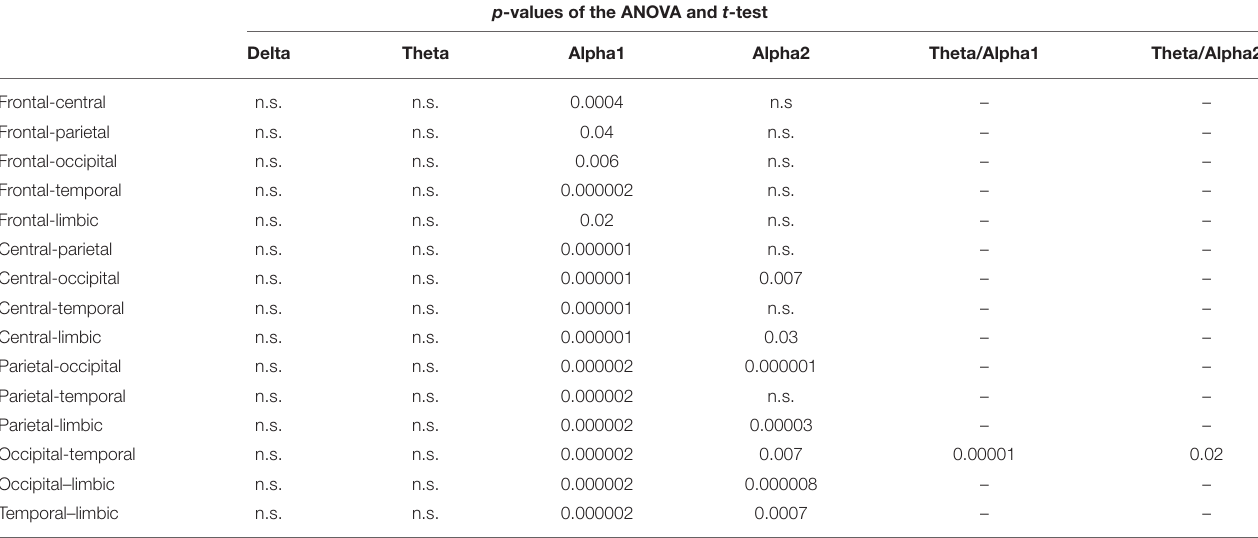
TABLE 6 | p -values (Duncan post-hoc ) of the ANOVA related to the comparisons of right intra-hemispherical lagged linear connectivity showing a statistically significant interaction interaction [ F (84 , 18312) = 4.6296, p < 0.0001] among the factors Group (AD, Nold), ROI pairs (frontal-central, frontal-parietal, frontal-occipital, frontal-temporal, frontal-limbic, central-parietal, central-occipital, central-temporal, central-limbic, parietal-occipital, parietal-temporal, parietal-limbic, occipital-temporal, occipital-limbic, and temporal-limbic), and Band (delta, theta, alpha 1, alpha 2, beta 1, beta 2, gamma) and p -values of the t -tests for each composite EEG